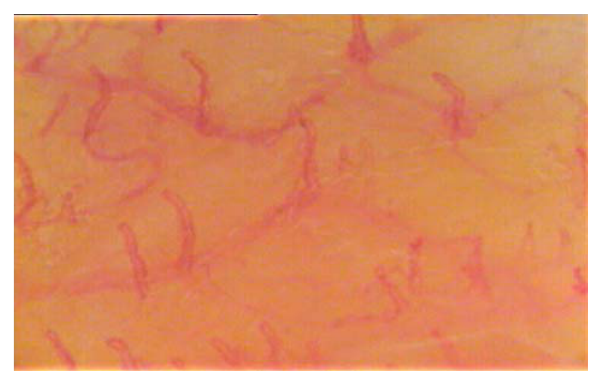
Figure 3. Oral microcirculation of healthy subject. (magni fi cation